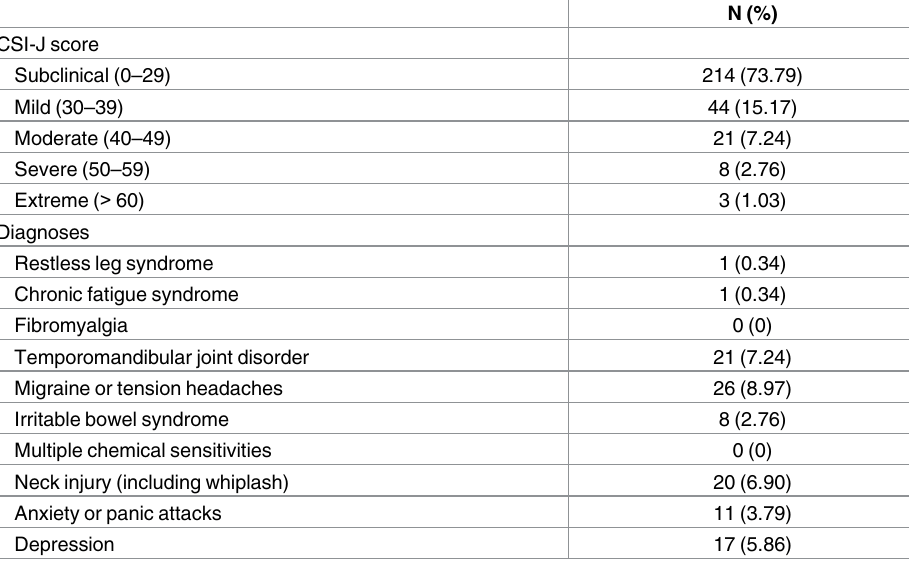
Table 3. Prevalence rates of CS severitylevels and frequency of diagnoses.